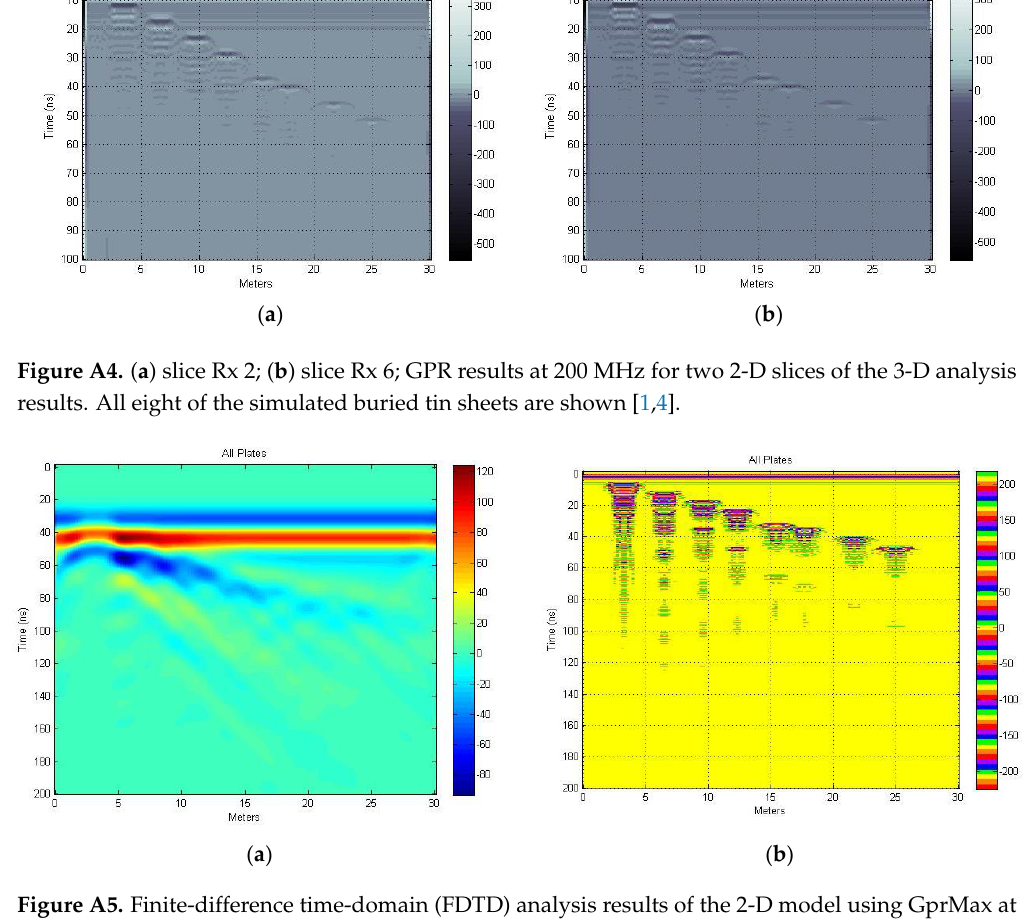
Figure A4. ( a ) slice Rx 2; ( b ) slice Rx 6; GPR results at 200 MHz for two 2-D slices of the 3-D analysis results. All eight of the simulated buried tin sheets are shown [1,4].